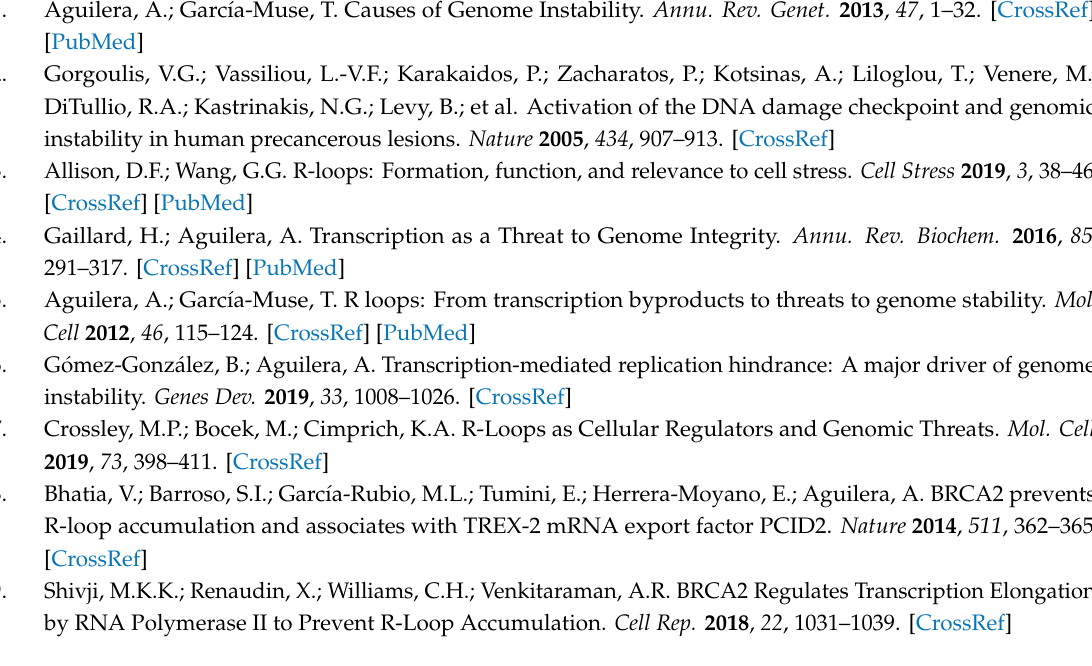
Figure S1: Down-regulation of WRN using siRNA performed in MRC5SV and shWRNIP1 cells and verified by WB, Figure S2: WB detection of chromatin binding of WRNIP1 in total extracts of WRN-wt and WRN-kd cells untreated or treated with Aph, Figure S3: Depletion of WRNIP1 using RNAi performed in WSWRN and WS cells and verified by WB, Figure S4: A) WB analysis of chromatin binding of WRNIP1 in WS cells, wild-type (WSWRN) or WS cells expressing a mutant form of WRN a ff ecting helicase function (WRN K577M ), treated or not with Aph; B) WB analysis of chromatin binding of WRNIP1 in WRN K577M cells exposed or not to Aph, and / or to 300 nM of CHK1 inhibitor, UCN-01, for the last 6 h; C) WB analysis of chromatin binding of WRNIP1 in WSWRN cells exposed or not to Aph, and / or to 300 nM UCN-01, Figure S5: Down-regulation of Claspin and TopBP1 performed in WSWRN cells using specific siRNAs and verified by WB, Figure S6: WB analysis of CHK1 phosphorylation in WSWRN cells transfected with GFP or WRNIP1 siRNA and treated or not with Aph for 8 and 24 h, Figure S7: Depletion of WRNIP1 using siRNA performed in WS cells and verified by WB, Figure S8: Depletion of WRNIP1 and TopBP1 using specific siRNAs performed in WSWRN cells and verified by WB, Figure S9: Representative images of ssDNA analysis in WS cells upon prolonged exposure to Aph, Figure S10: WB analysis of level of phospho-CHK1 in WS cells after transfection of FLAG-tagged CHK1 317 / 345D , Figure S11: Representative images of parental ssDNA exposure in WS cells after RNaseH1 over-expression, Figure S12: Evaluation of ssDNA accumulation at parental-strand by immunofluorescence analysis in WS cells depleted of XPG by siRNA, Figure S13: Representative images of parental ssDNA in WSWRN cells depleted of TopBP1 depletion and treated with Aph and